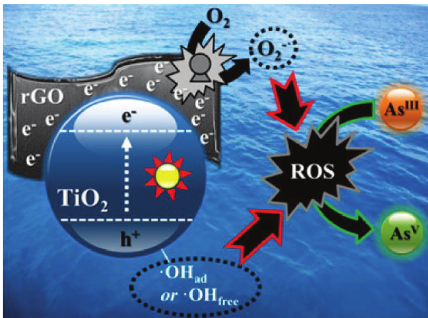
Figure 2: Schematic presentation of the mechanism of TiO 2 photo- catalytic process. Reprinted from [59] with permission. Copyright © 2014, American Chemical